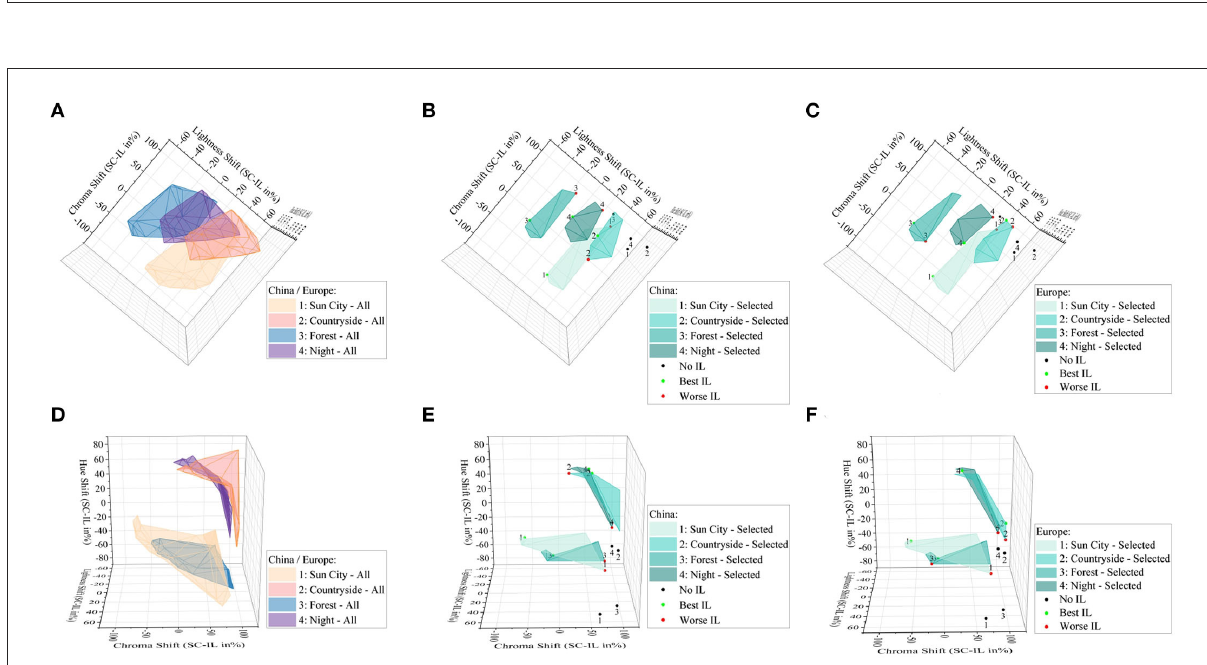
FIGURE8 (A–C) 3D plots of lightness shift 1 J , (A–C) chroma shift 1 c and (D–F) hue shift 1 h . (A–F) Plots are rotated only to show single dimensions. Maximum possible lightness and chroma shift within all displayed luminaire and brightness settings (A) and hue ranges (D) . Selected preferences (B,C) according to best and worst ratings as displayed in Figures 6B,C. Hue differences between best and worst (E,F) . All separated between the Europe and China